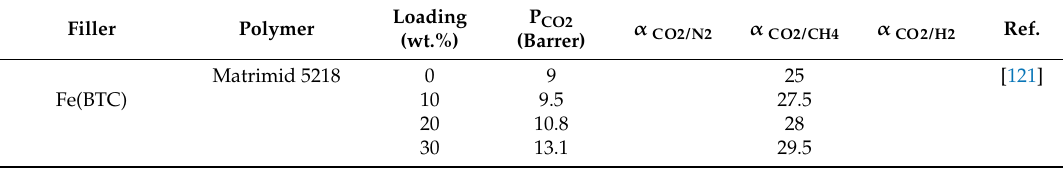
Table 5. Gas separation performance of different MOFs (Fe(BTC), KAUST-7, Mg 2 (dobdc)) used